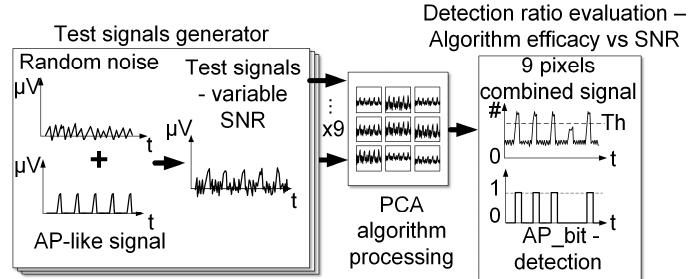
Figure 14. Behavioral setup functional scheme.